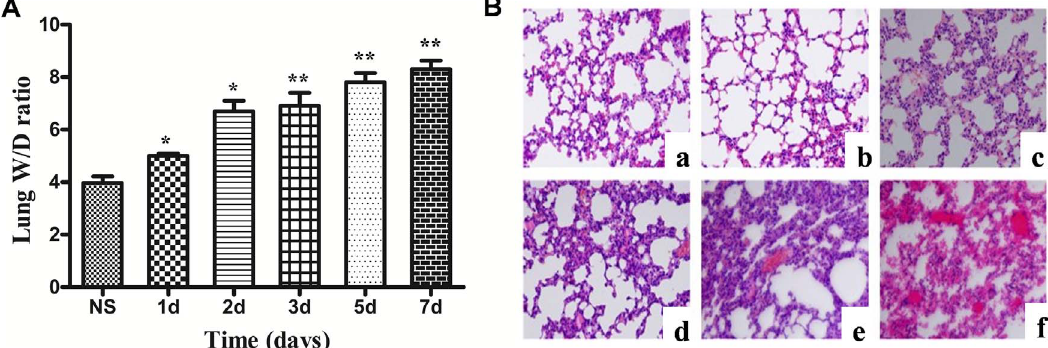
Figure 1. Lung W/D ratio (A) and histology (B). The lungs were stained with hematoxylin-eosin (original magnification: 40 6 ). NS (a), 1d after the injection of zymosan (b), 2d after the injection of zymosan (c), 3d after the injection of zymosan (d), 5d after the injection of zymosan (e), and 7d after the injection of Zymosan (f). The values show the means 6 SEM (n=6 for each group). * P , 0.05 compared with the NS-treated group; ** P , 0.01 compared with the NS-treated